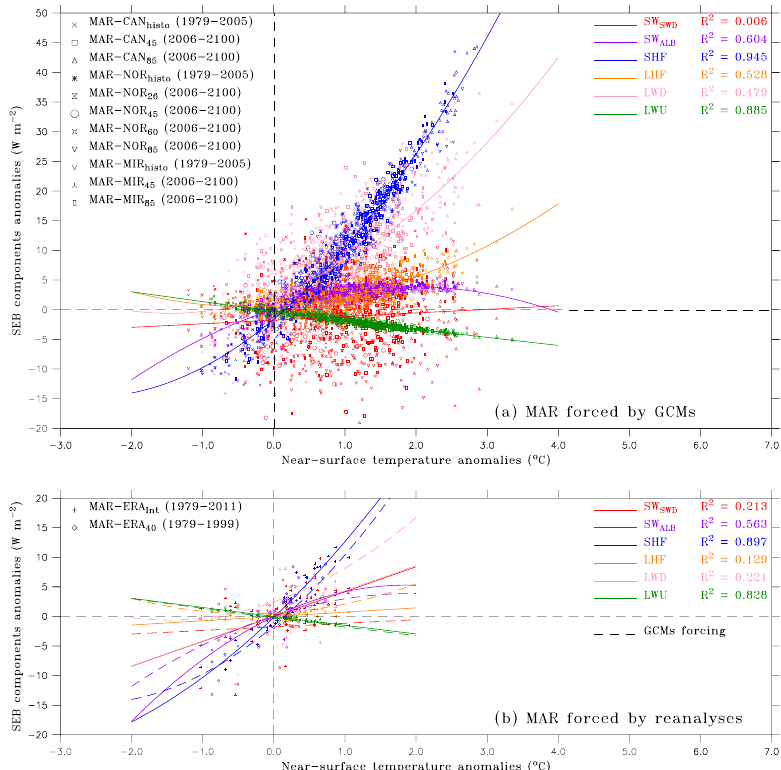
Fig. 8. The same as Fig. 5, but on the 1980–1999 MSK ice .